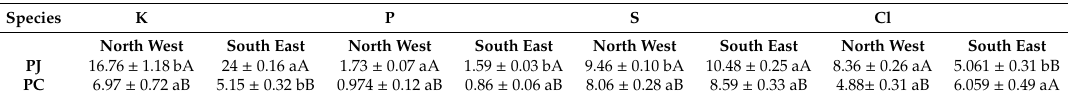
Table 5. Di ff erent elemental concentrations in leaves of Prosopis juliflora (PJ) and Prosopis cineraria (PC) at di ff erent canopy position (south east and north west).